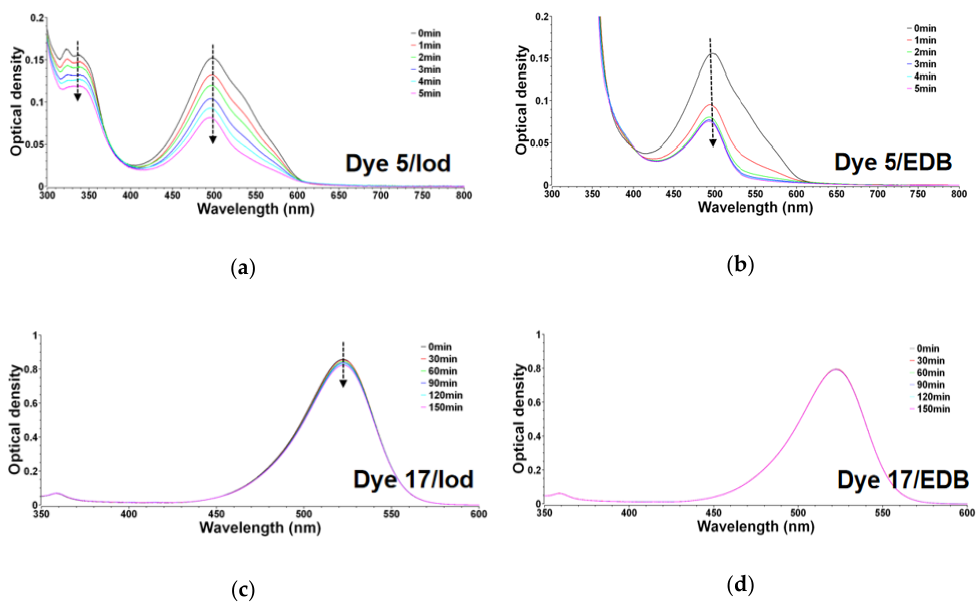
Figure 4. UV-visible absorption spectra of dyes 5 , 17 (1.04 × 10 − 5 M; 9.20 × 10 − 6 M, respectively.) (left) in the presence of the iodonium salt (Speedcure 938, 1.46 × 10 − 4 M) upon exposure to LED@405nm under air in the solvent of acetonitrile: ( a ) dye 5 , ( c ) dye 17 and (right) in the presence of the amine (Speedcure EDB, 4.07 × 10 − 4 M) upon exposure to LED@405nm under air in the solvent of acetonitrile: ( c ) dye 5 , ( d ) dye 17